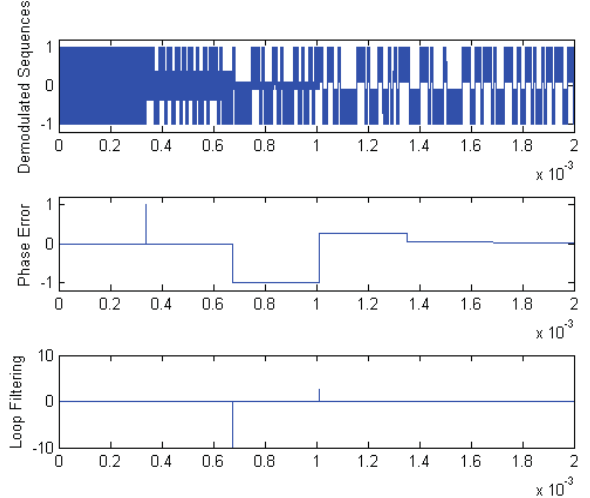
Figure 22. Simulation result of code